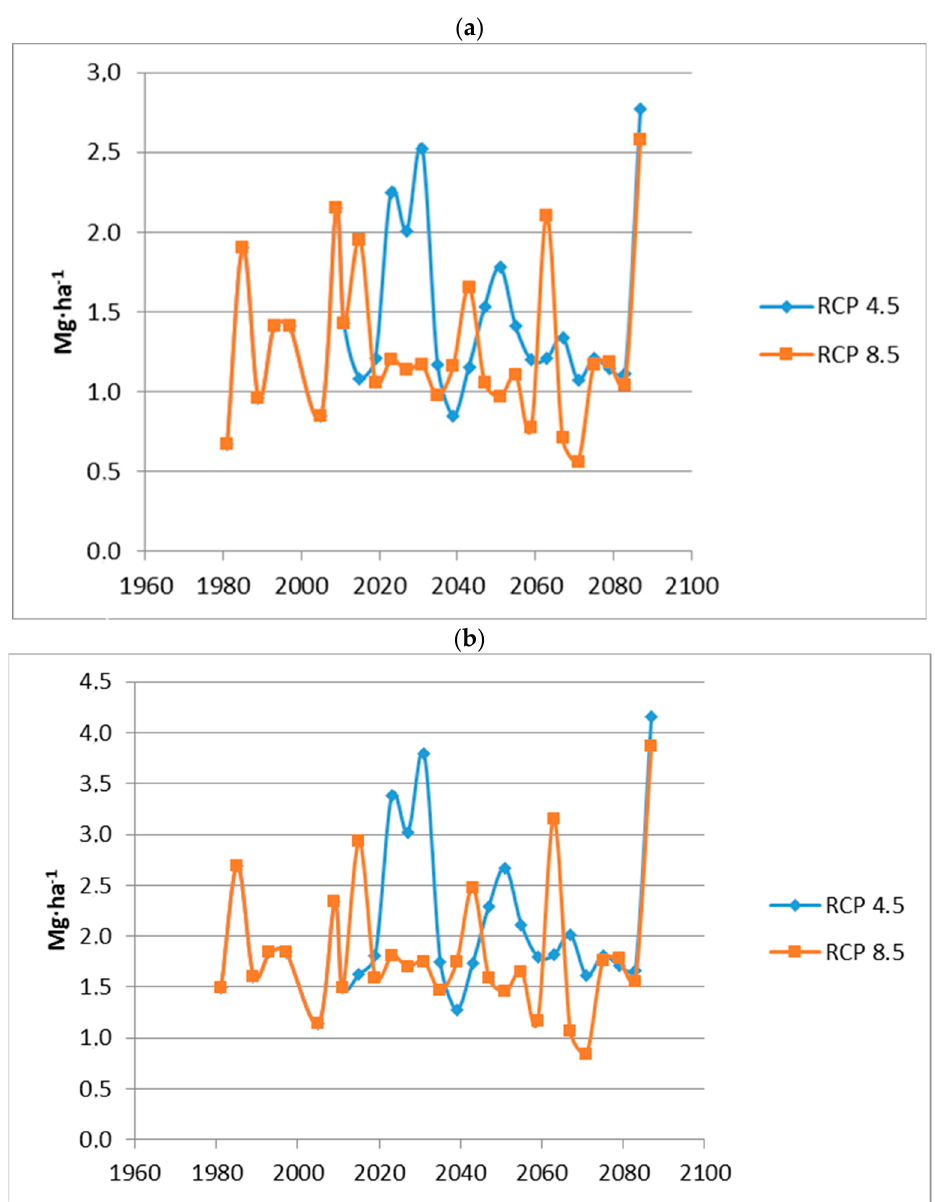
Figure 1. Observed (1980–2011) and simulated (2012–2090) yields of winter: ( а ) control and ( b ) NPK1. RCP: Representative Concentration Pathways.